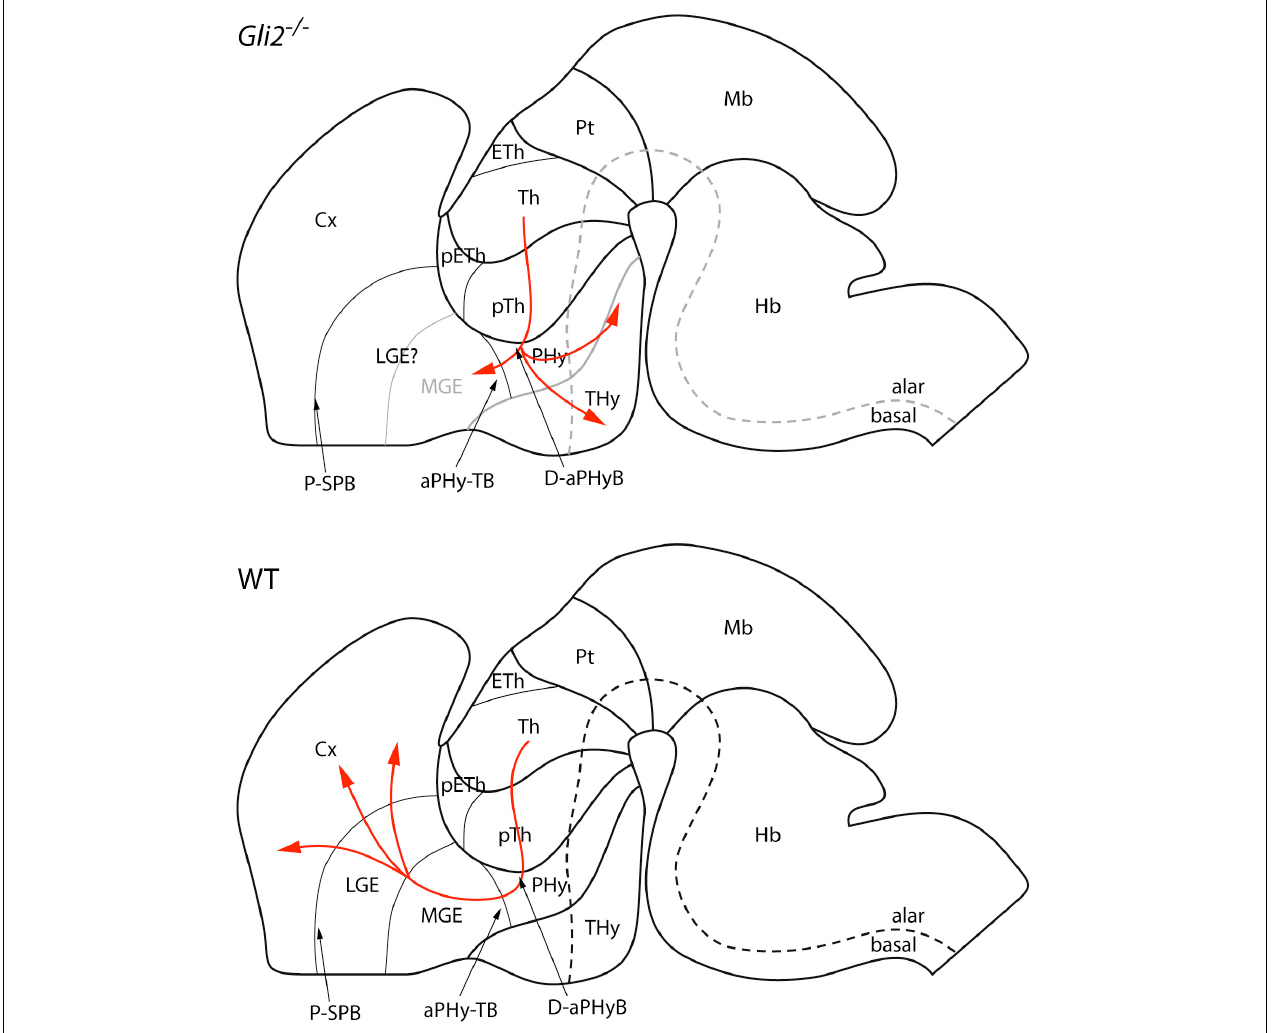
FIGURE 7 | Schematic representation of thalamocortical projections in Gli2 mutant and wild type in the context of the prosomeric model. aPHy-TB, alar peduncular hypothalamus-telencephalic boundary; Cx, cortex; D-aPHyB, diencephalon alar peduncular hypothalamus boundary; Eth, epithalamus; Hb, hindbrain; LGE, lateral ganglionic eminence; Mb, midbrain; MGE, medial ganglionic eminence; pETh, prethalamic eminence; PHy, peduncular hypothalamus; THy, terminal hypothalamus; P-SPB, pallial-subpallial boundary; Pt, pretectum; pTh, prethalamus; Th,